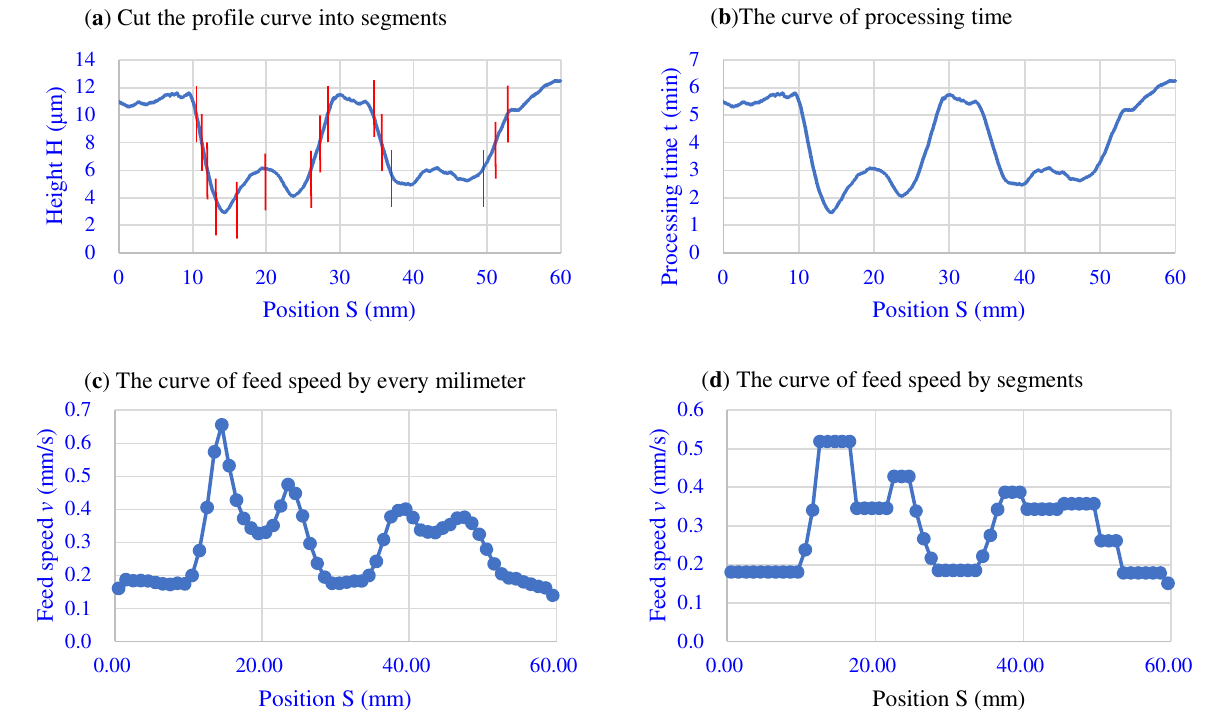
Figure 3. The curves of dividing the height, time and speed into segments.